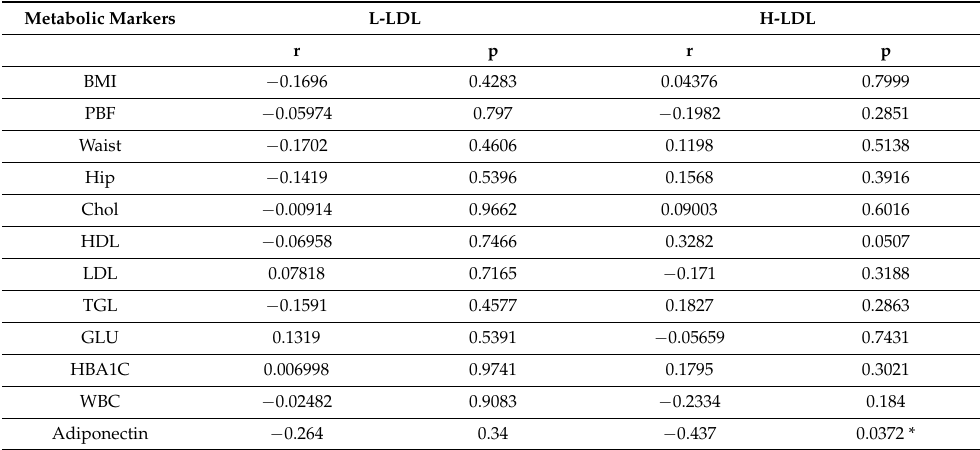
Table 6. Association between adipose tissue IL-23 expression and metabolic parameters in people with H-LDL-c.